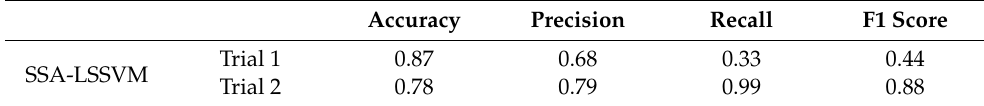
Table 10. Performance of the SSA-LSSVM model based on reduced dimensional